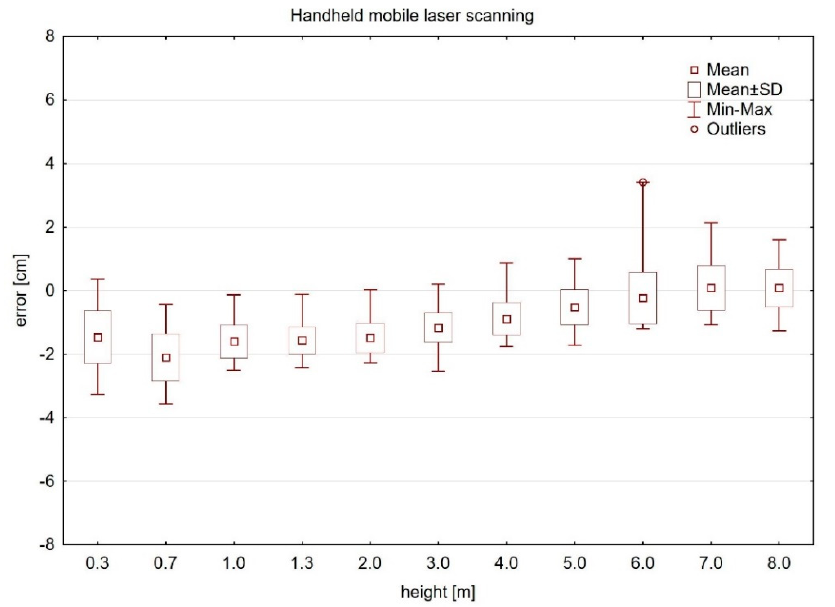
Figure 6. Diameter estimation errors in HMLS point cloud cross sections.